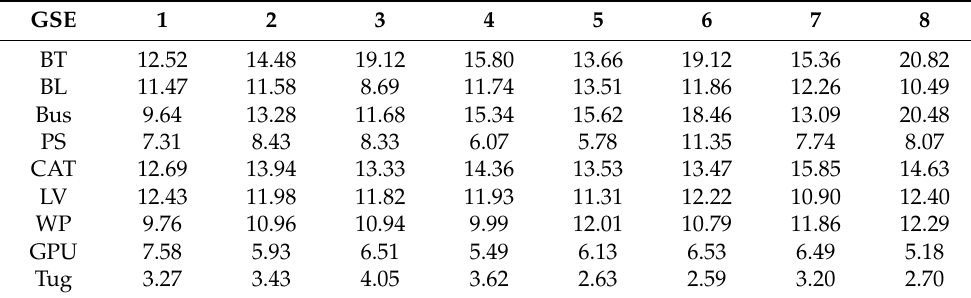
Table 7. Total amount of covered kilometers per vehicle.